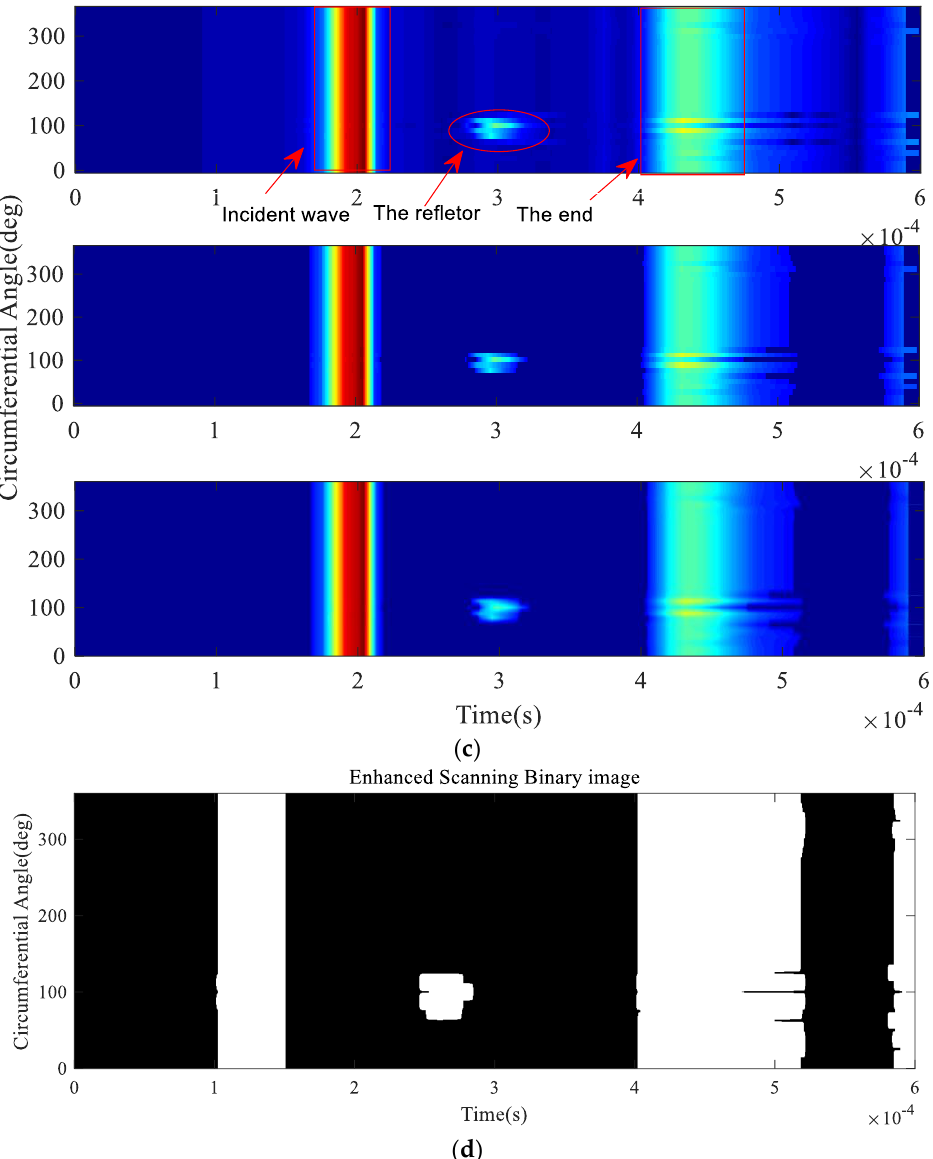
Figure 11. Analysis results based on the proposed method: ( a ) the upper envelopes of the guided-wave simulation signals: ( b ) 3D representation of the reflector; ( c ) original 2D scanned image ( Up ), enhanced 2D scanned image ( Middle ) and smoothed 2D scanned image ( Down ); ( d ) enhanced 2D scanned binary image.